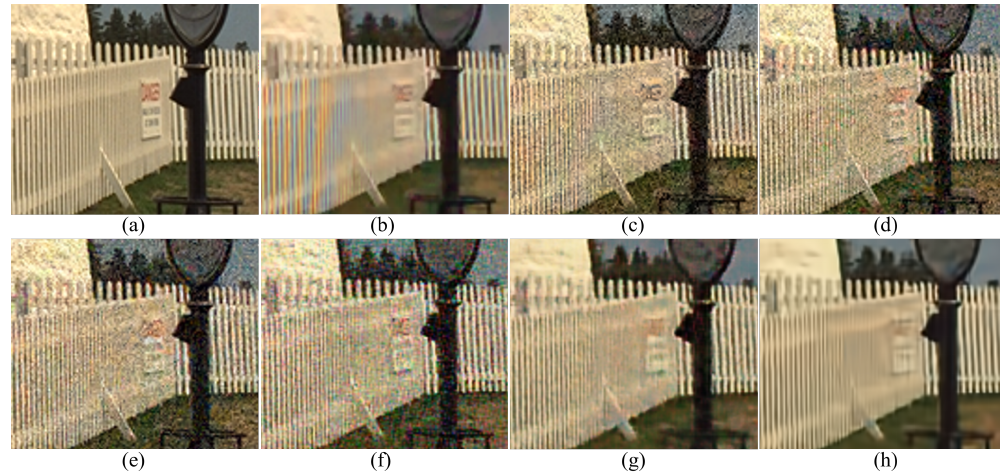
Figure 8. Enlarged regions of the denoising results on the Kodak number 19 image with noise levels σ R = 26.22, σ G = 16.64 and σ B = 18.23. ( a ) Original, ( b ) ADMM, [28] ( c ) SEM, [14] ( d ) DNetB, [15] ( e ) DNetX, [15] ( f ) DIP, [19] ( g ) proposed and ( h ) proposed +